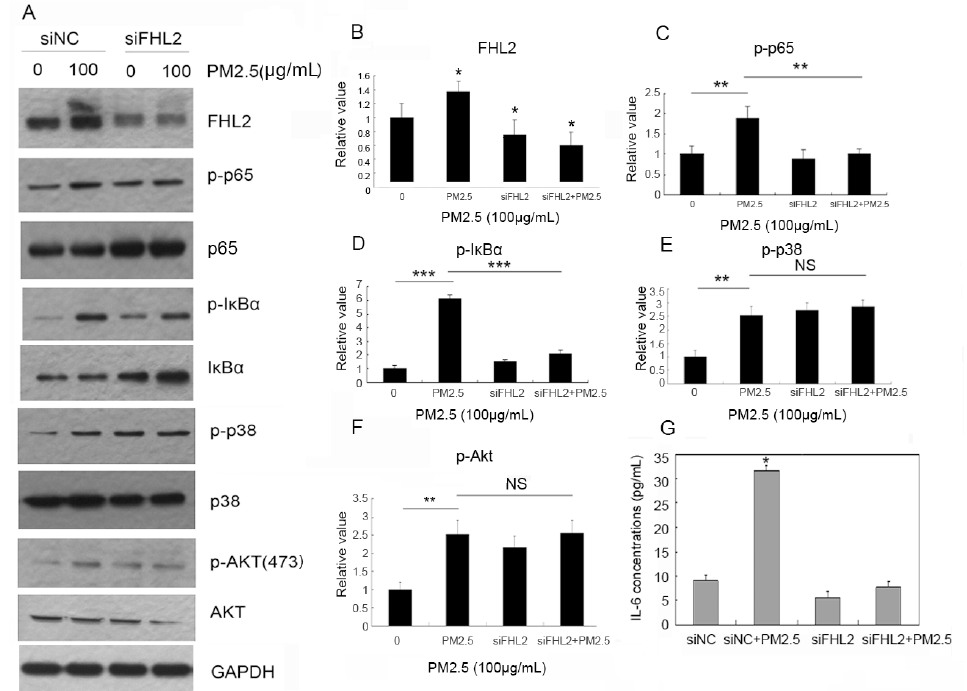
Figure 2. FHL2 mediates PM2.5-induced NF- κ B activation. ( A ) Cells were transfected with si FHL2 or negative control siRNA (siNC) for 48 h, followed by exposure to PM2.5 at a final concentration